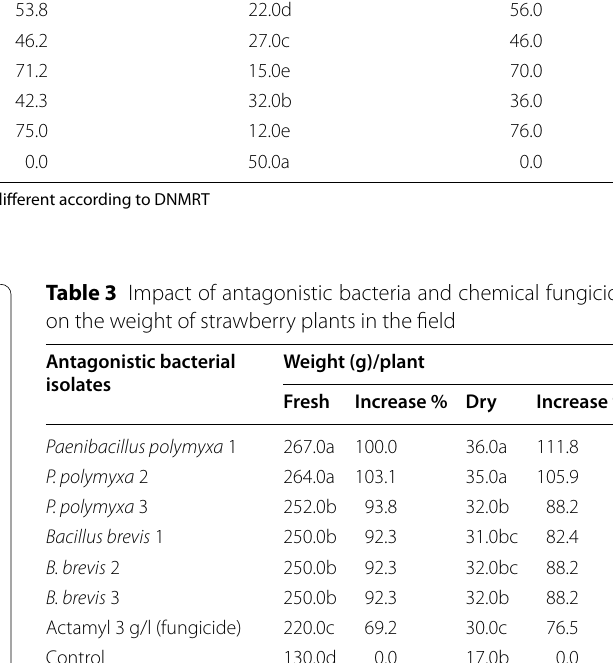
*Means in a column followed by the same letter are not significantly ( P different according to DNMRT